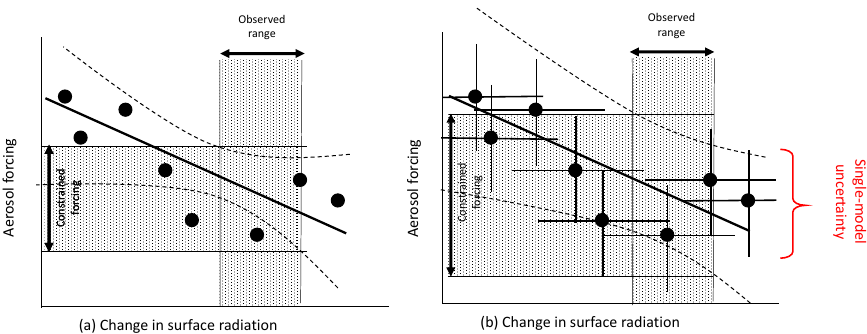
Figure 10. An example of an emergent constraint of the aerosol forcing using results from multiple models. (a) A relatively tight apparent constraint when the uncertainty in the individual models is neglected; (b) a much weaker constraint when the uncertainty in the individual models is accounted